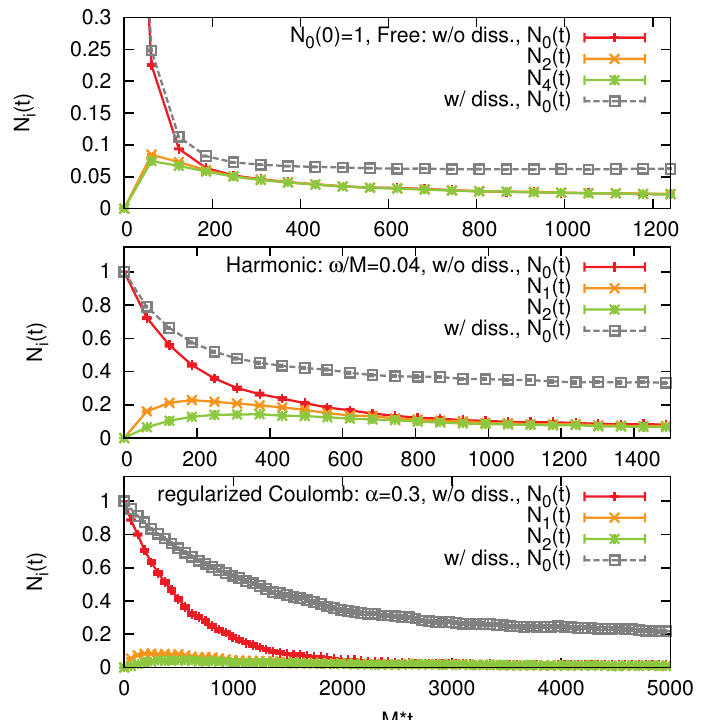
Figure 7 . Time evolution of the occupation number of the eigenstates without dissipation. For comparison, the time evolution with dissipation is also plotted. The bars denote statistical